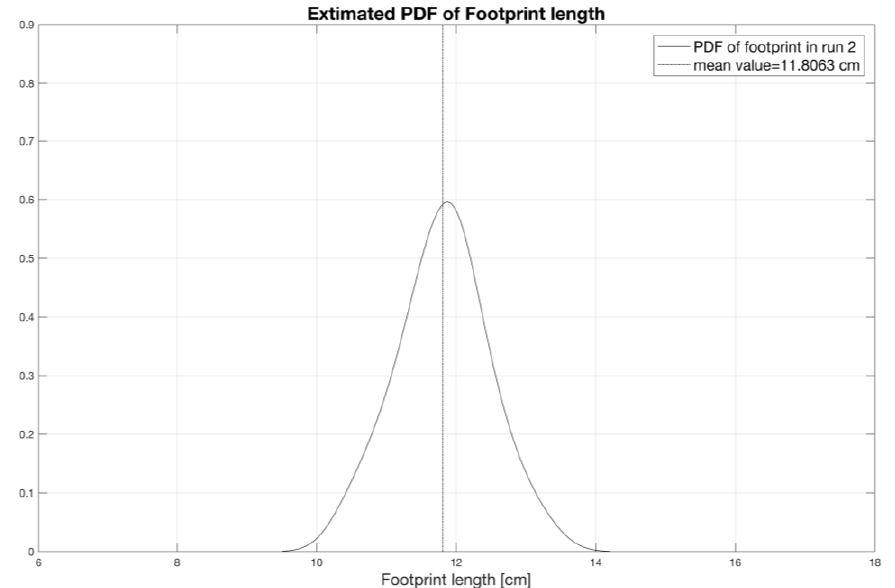
Figure 27. Contact length PDF in two different tests.